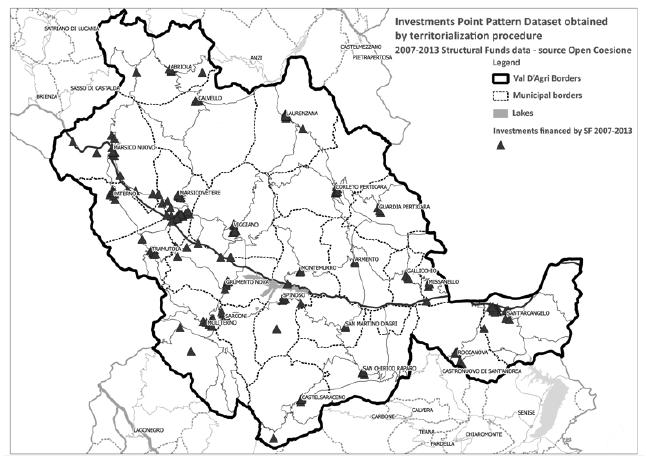
Figure 3. Investments point pattern in Agri Valley. Table 1 describes the accuracy level and specific uncertainty causes in